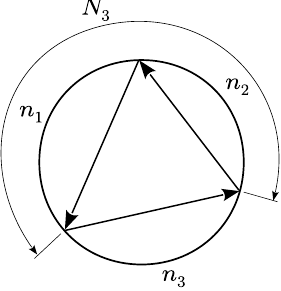
Figure 5 . Phases of gauge theories related by triality. Their parameter spaces can be glued to each other as shown.